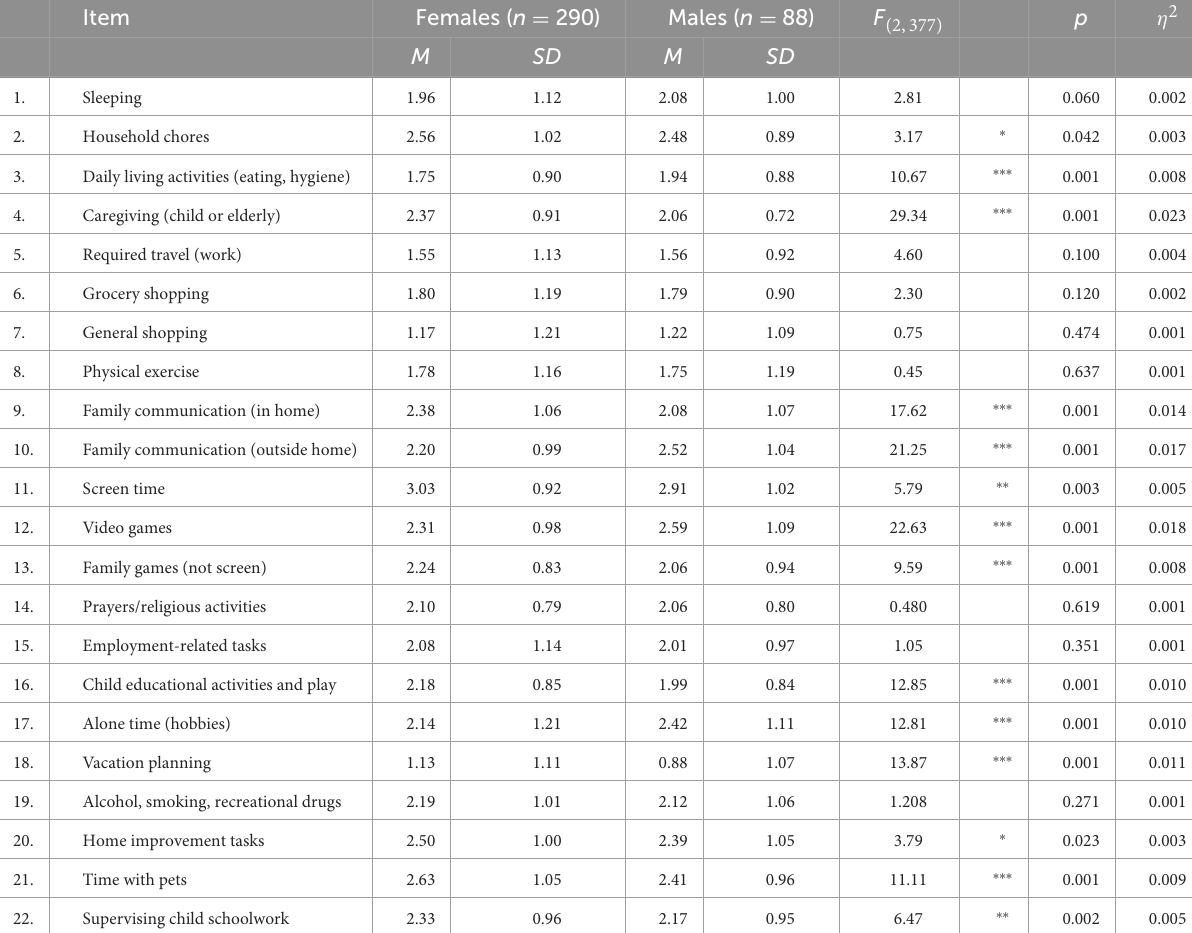
TABLE 1 Gender differences in daily time spent on family routines before and during